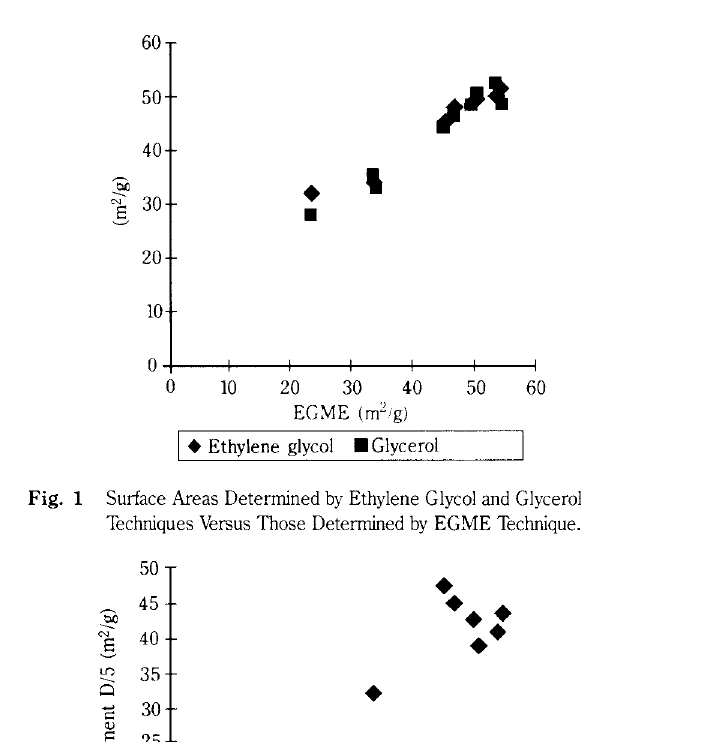
Fig. 1 Surface Areas Determined by Ethylene Glycol and Glycerol Techniques Versus Those Determined by EGME Technique.